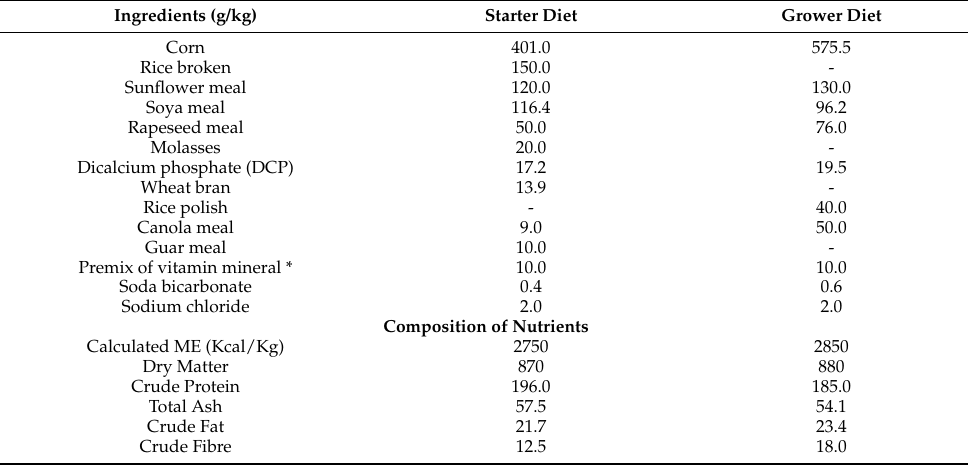
Table 1. Ingredients in starter (1–21 days) and grower (22–35 days) feed for